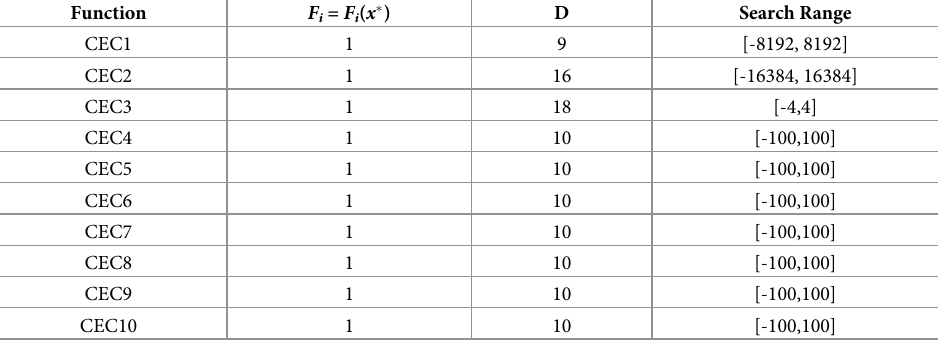
Table 1. CEC 2019 benchmark